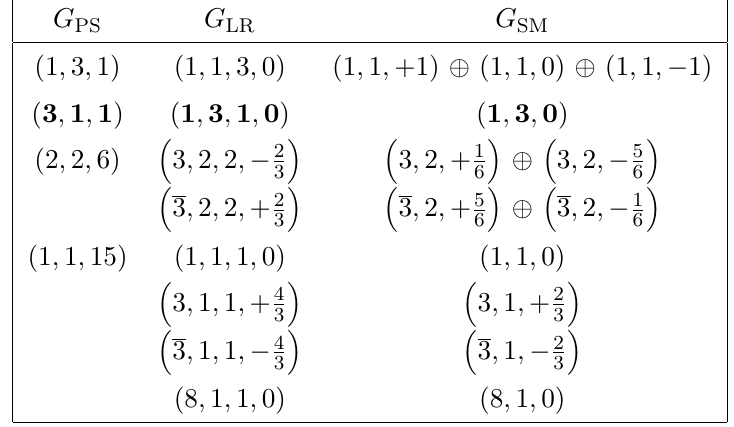
Table 8 . Decomposition for the representation 45 of SO(10) under G PS , G LR , and G SM . We highlight the representations relevant to the discussion in the main text in